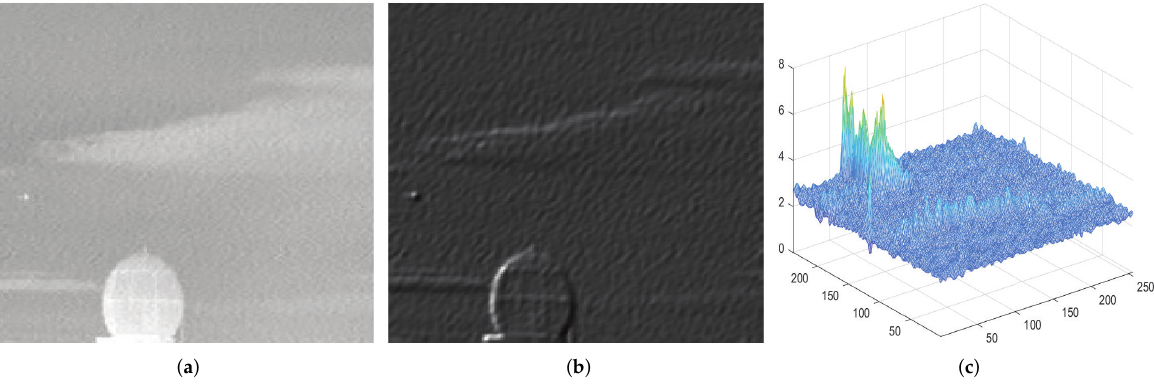
Figure 1. The featured image of OEI. ( a ) original image. ( b ) OEI feature image. ( c ) three-dimensional image of